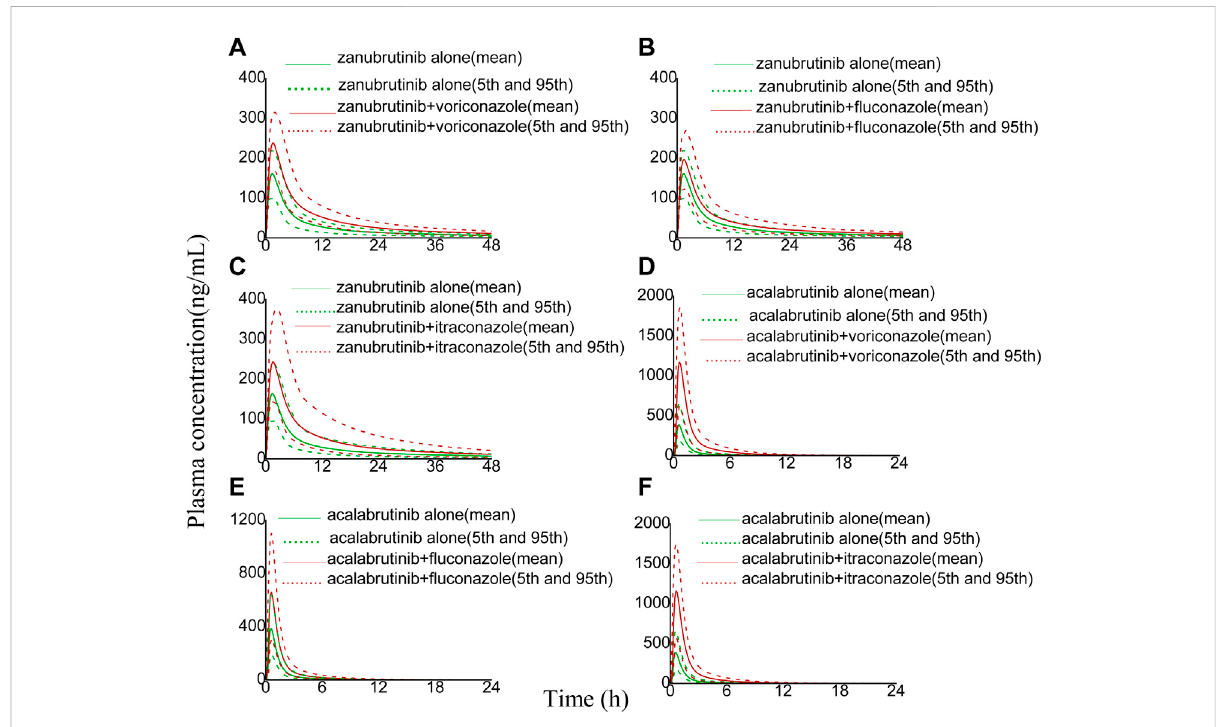
FIGURE 3 Simulated plasma concentrations of a single-dose zanubrutinib (160 mg) dosed alone or concomitant with (A) voriconazole (200 mg), (B) fl uconazole (200 mg), (C) itraconazole (200 mg), and a single-dose acalabrutinib (100 mg) dosed alone or concomitant with (D)